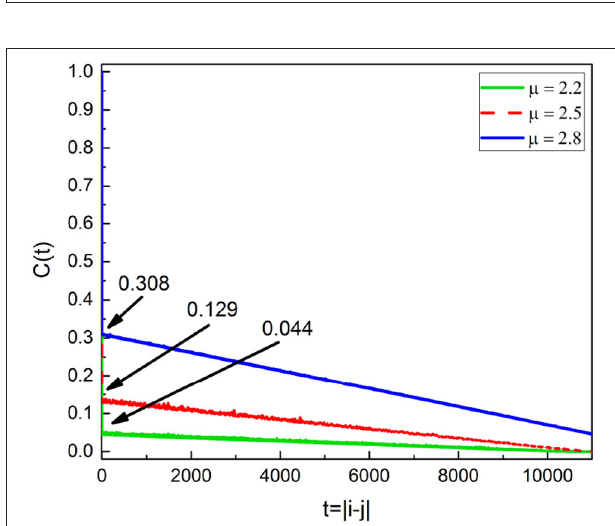
FIGURE 9 | Correlation rate C( t = | i − j | ) of Equation (4) for the subordinated oscillator with (cid:127) = 0.8 . From the top, the blue, red and green curves are for µ = 2.8,2.5 and 2.2 respectively. As µ decreases C(1) decreases as